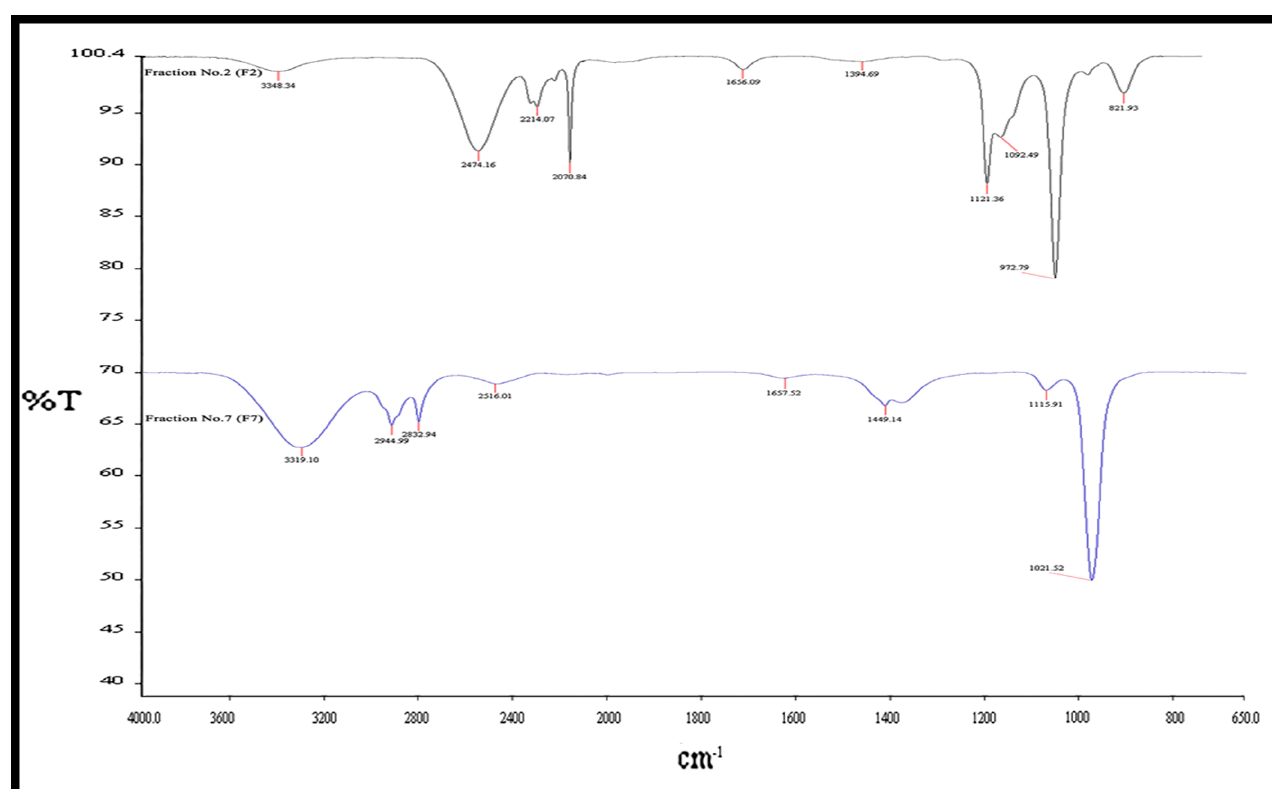
Figure 2. The Fourier transform infrared spectroscopy for fraction number 2 and 7.